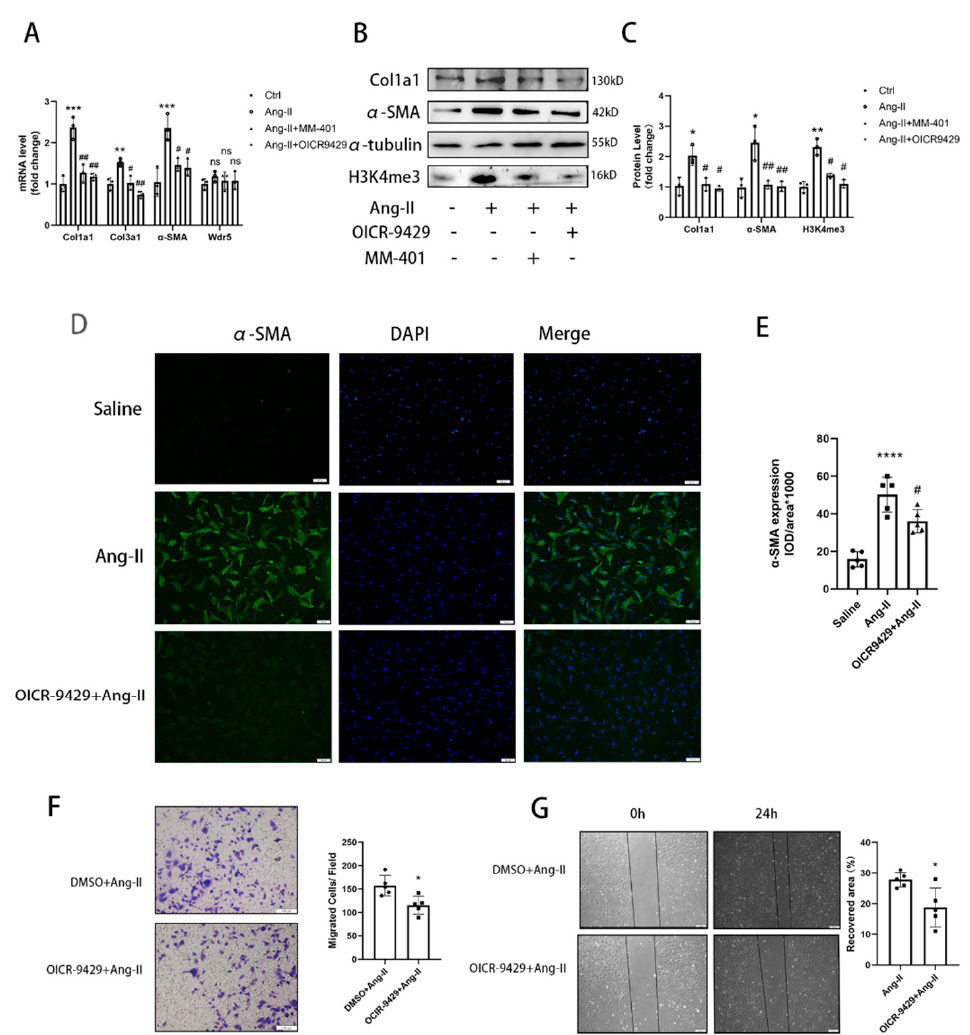
Figure 3. Pharmacologic inhibition of Wdr5 suppressed the FMT process. ( A ) Application of MM- 401 and OICR-9429 repressed the Ang-II-induced col1a1, col3a1, and α -SMA. ( B ) Protein levels of col1a1 and α -SMA were downregulated after the application of MM-401 and OICR-9429. ( C ) is the quantitative analysis of graph ( B ). ( D ) Immunofluorescence analysis of α -SMA demonstrated inhibited α -SMA by OICR-9429 (green, α -SMA; blue, DAPI, Scale bar 100 µ m). ( E ) is the quantitative statistics of graph ( D ) ( n = 5 in each group, >3 fields in each sample). ( F ) Representative images of transwell migration assay and the quantification of migrated NRCFs ( n = 5 in each group, >3 fields in each sample). ( G ) Wound repair assays were performed to assess the migratory capacities of cells that have been treated with DMSO or OICR-9429 ( n = 5 in each group, >3 fields in each sample). Scale bar 100 µ m. Data are presented as mean ± SEM. * p < 0.05, ** p < 0.01, *** p < 0.001, **** p < 0.0001 vs. saline, # p < 0.05, ## p < 0.01 vs. Ang II group. The H3K4me3 methyltransferase is activated by forming a complex with Wdr5 [17,21,24]. There are two overlapping sites on Wdr5 to directly interact with other proteins, which are the “Wdr5-binding motif” (WBM) site and the “Wdr5-interacting” (Win) site. OICR-9429 and MM-401 are known to inhibit the HMT activity of Wdr5 complexes by interacting on its Win site [21,27]. To further validate the role of Wdr5 in FMT, we administered OICR-9429 and MM-401 to neonatal rat cardiac fibroblasts for 48 h before the administration of Ang II. Increased contractile function of fibroblasts was associated with increased expression of α - SMA mRNA and protein, indicating increased myofibroblast differentiation (Figure